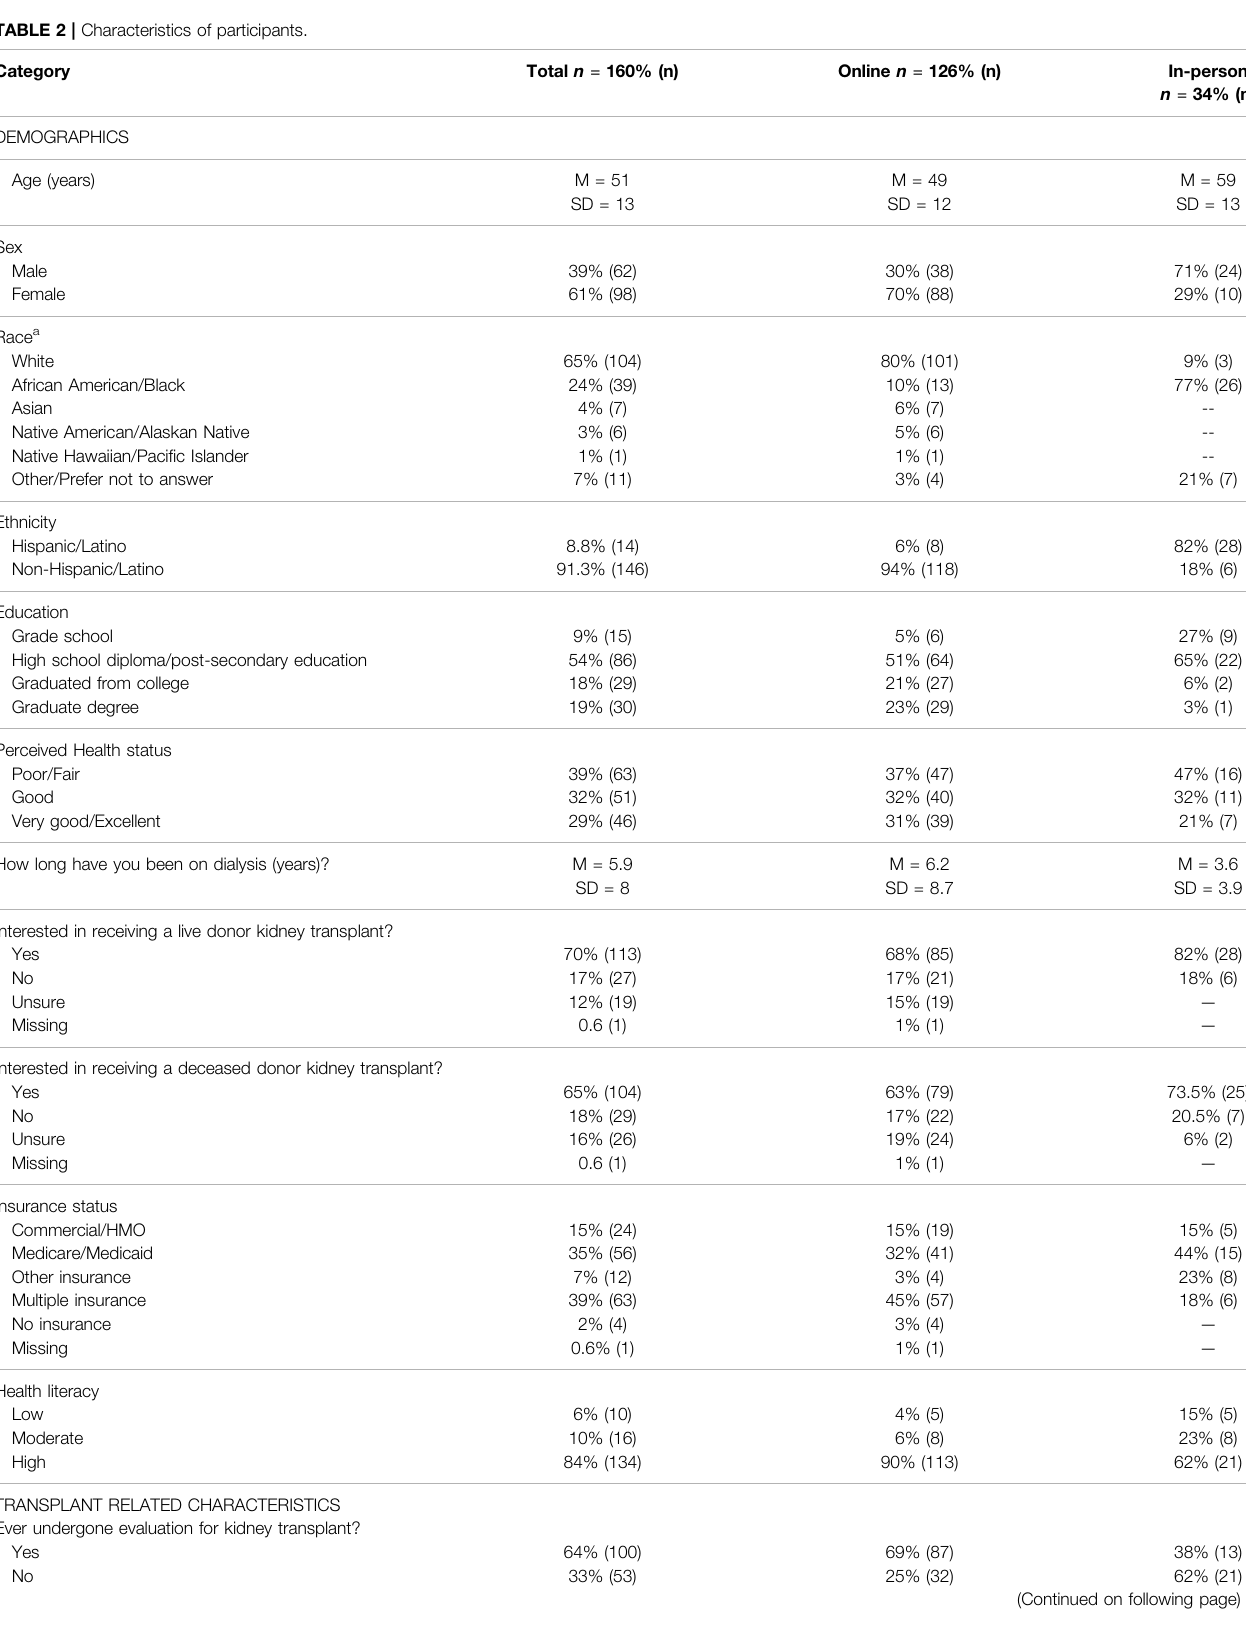
TABLE 2 | Characteristics of